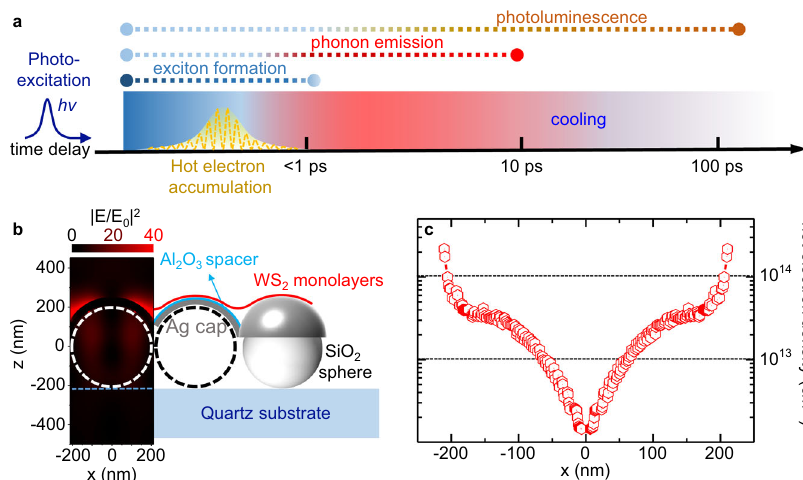
Fig. 4 Hot electron doping and density. a Schematic illustration of the overall relaxation scenario after pulsed optical excitation on the PC-WS 2 systems, where the yellow oscillating dashed curve stands for repeated hot electron population in lattice; dotted lines above correspond to the time durations of different relaxation processes; h ν refers to energy of the pump pulse; b simulated intensity distribution E = E 0 section at middle of the sphere) at the frequency of 2.05 eV, together with a schematic of the PC-WS 2 sample; please note that the WS 2 ML is partially suspended at interstices between two Ag caps, but not fully covering the metal surface; detailed morphology can be referred to our previous work 15 ; c calculated hot electron density along the curved WS 2 surface as a function of distance along the projected x -direction (at the same cross-section as in b